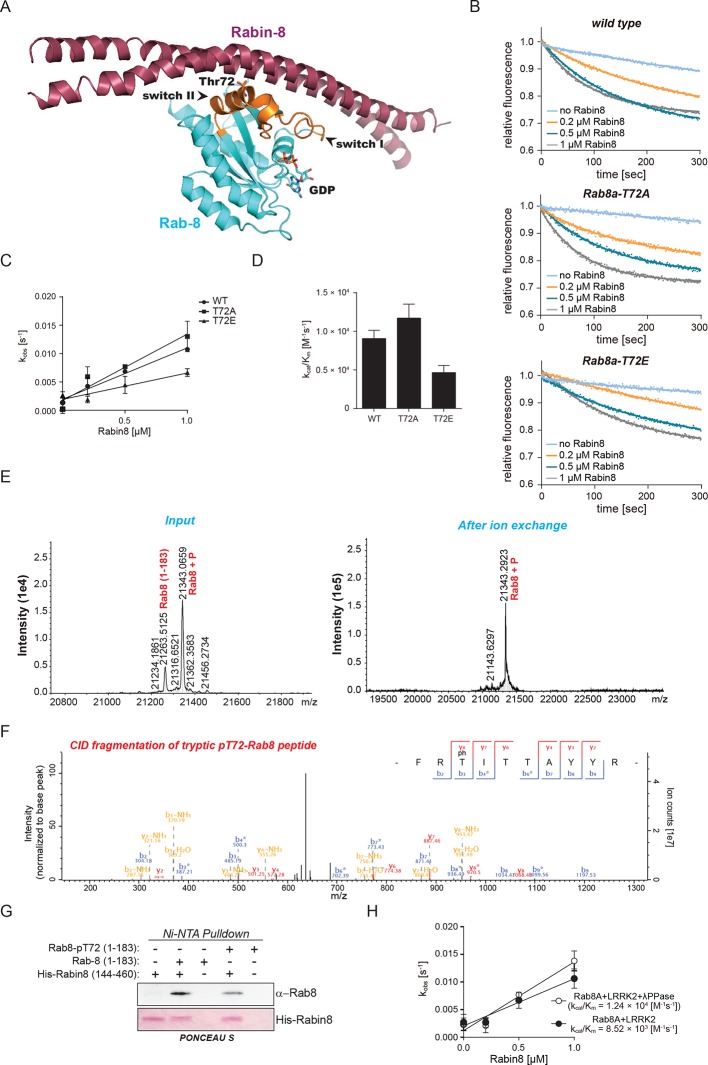
Rab8a guanine nucleotide exchange assays.(A) Ribbon structure of Rab8a in complex with Rabin8 (PDB: 4LHY). The LRRK2 phosphorylation site (T72) situated in the switch II region and forming close contact with Rabin8 is indicated. (B) Kinetics of mant-GDP dissociation from Rab8a (wt, T72A, and T72E) by Rabin8. (C) and (D) Representation of the observed rate constants (kobs) and catalytic efficiencies (kcat/Km) for the same reactions. (E) ESI-TOF mass determination of Rab8a after in vitro phosphorylation by LRRK2-G2019S (left) and after enrichment of phosphorylated Rab8a by ion-exchange chromatography (right). (F) Collision-induced dissociation (CID) fragmentation spectrum of the tryptic pT72-Rab8a peptide, which was identified after phosphorylation of Rab8a by LRRK2 followed by enrichment of the phosphorylated form by ion exchange chromatography. (G) Ni2+-NTA pull-down of Rab8a (non-phosphorylated or phosphorylated on T72) by HIS-tagged Rabin8 using purified components. (H) Representation of the observed rate constants (kobs) and catalytic efficiencies (kcat/Km) for the indicated reactions. Error bars are mean ± SD (n=3).